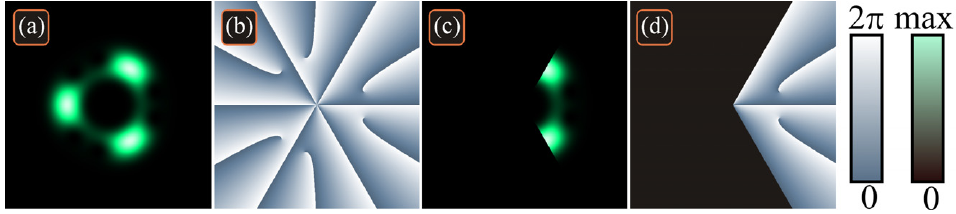
Figure 5. Intensity ( a , c ) and phase ( b , d ) distributions of a superposition of three single-ringed LG beams with different energies, untruncated ( a , b ) and truncated ( c , d ) by a sector aperture with the half-angle π /3.